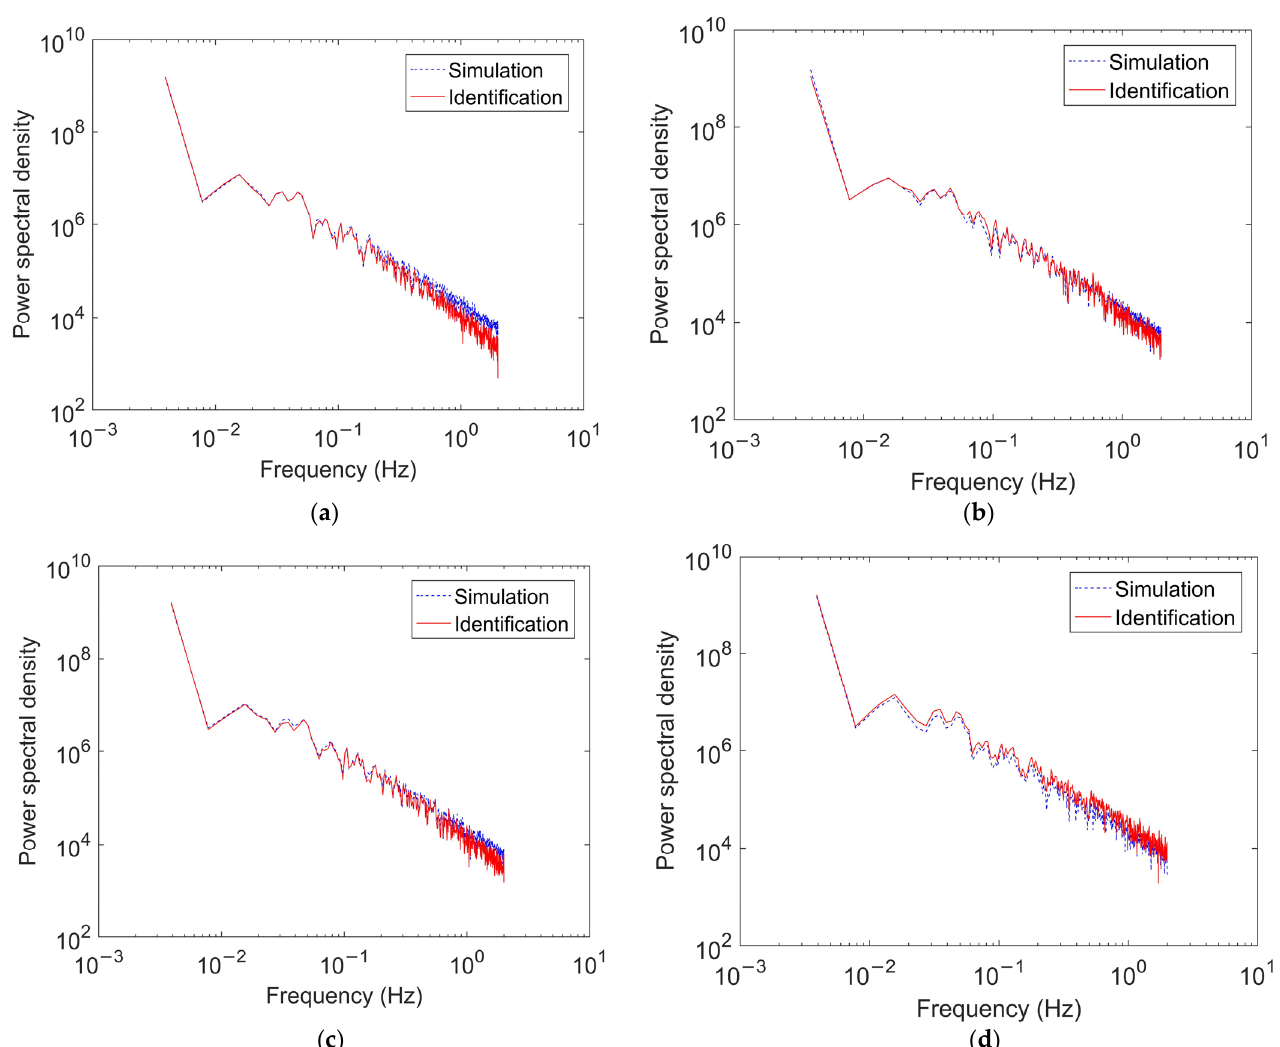
Figure 4. Comparison of wind loads in frequency domain at ( a ) 5 m level, ( b ) 20 m level, ( c ) 40 m level and ( d ) 60 m level. Table 1. RMS error of the identified wind loads on the continuous system.